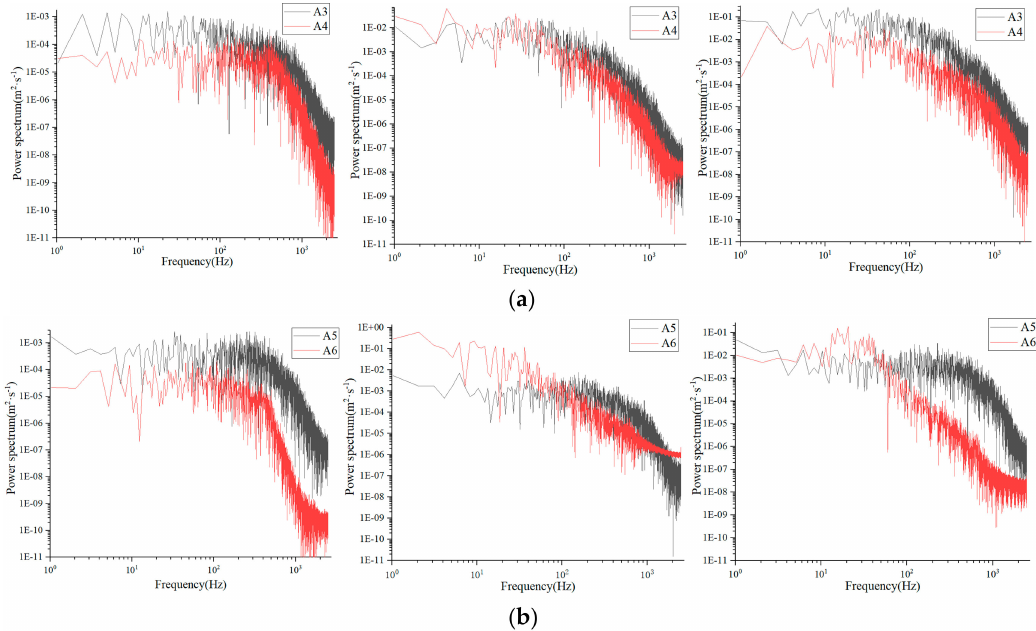
Figure 16. Power spectrum of fluctuating velocity in three directions: ( a ) A3 and A4 (u x ’, u y ’, and u z ’); and ( b ) A5 and A6 (u x ’, u y ’, and u z